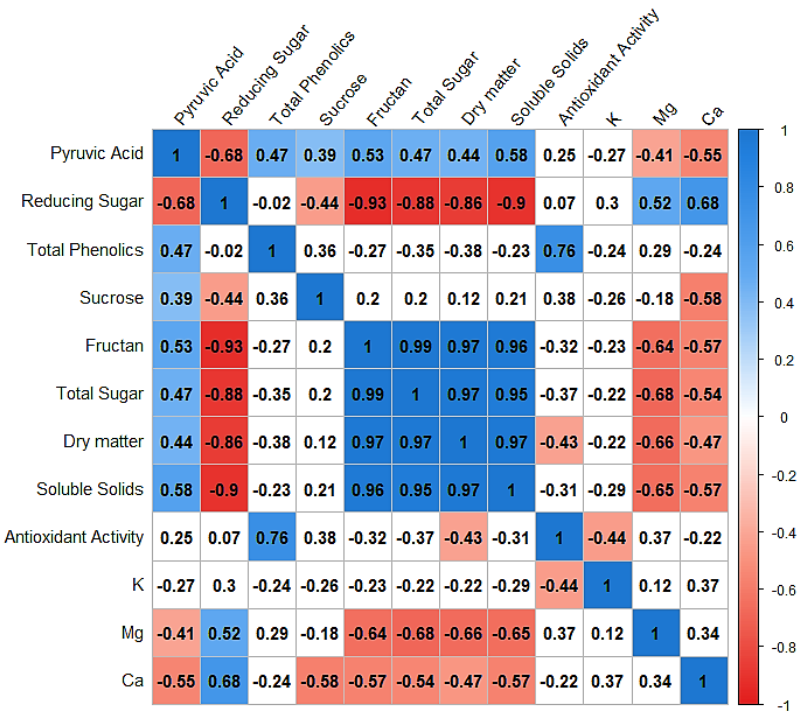
Fig. 6: Correlation matrix of the most important quality traits in the studied onion varieties. Correlations with p-value < 0.01 are considered as significant and are highlighted: Red = negative correlation, Blue = positive correlation. Non significant coefficient values are not